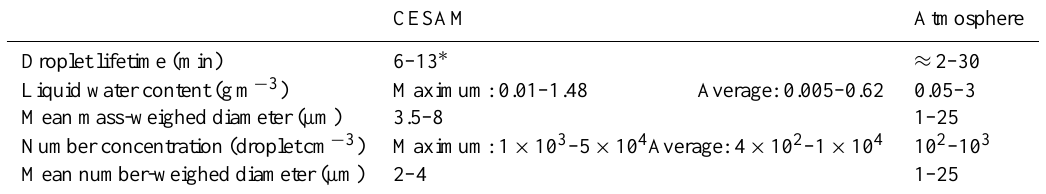
Table 1. Comparisons of cloud properties between clouds generated in CESAM (23 clouds) and atmospheric clouds (Colvile et al., 1997; Herrmann, 2003).